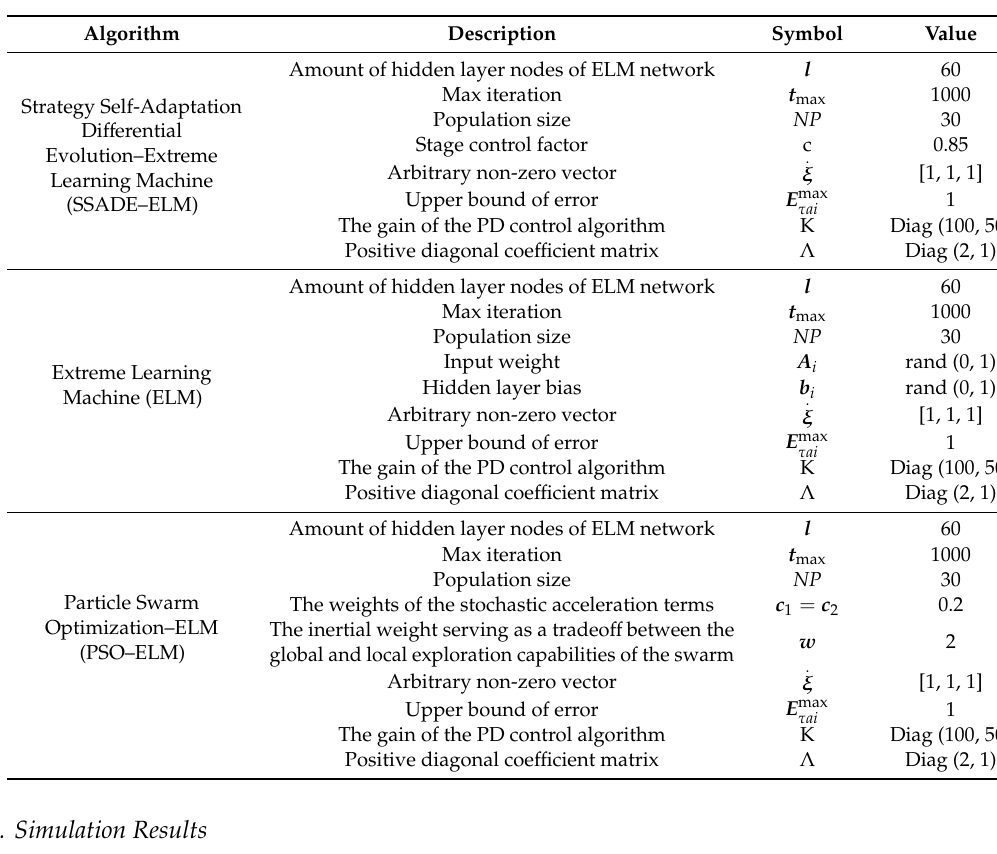
Table 2. The parameters of the adaptive control algorithm.